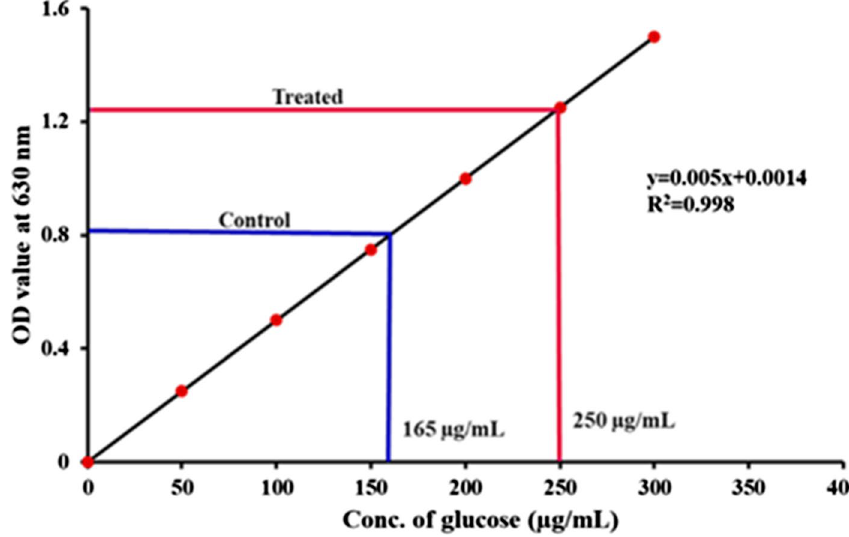
Fig. 4 Estimation of carbohy- drate content from microalgae Chlorella